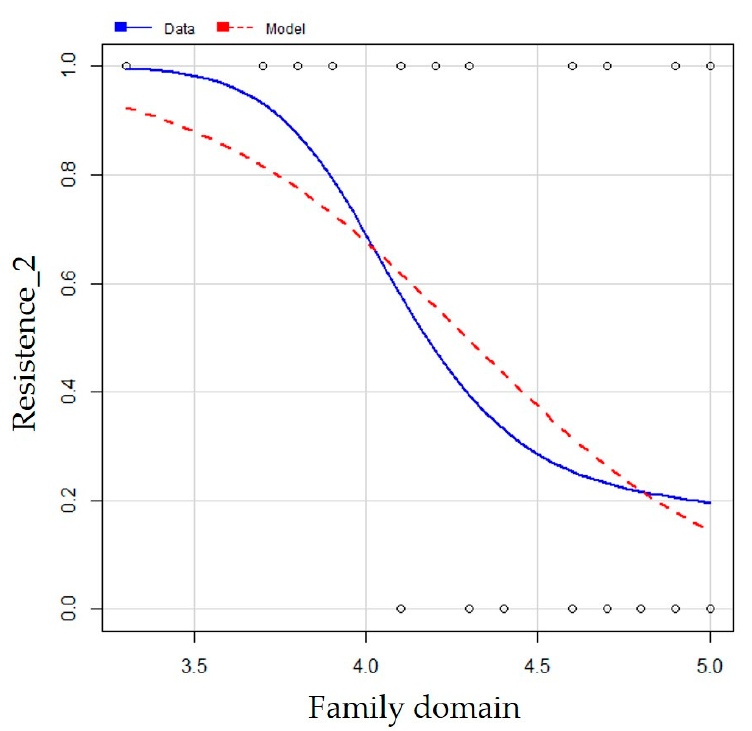
Figure 1. Observed data of the variable resistance_2 and fitted data of the model. Source: Data Bank of this Research.